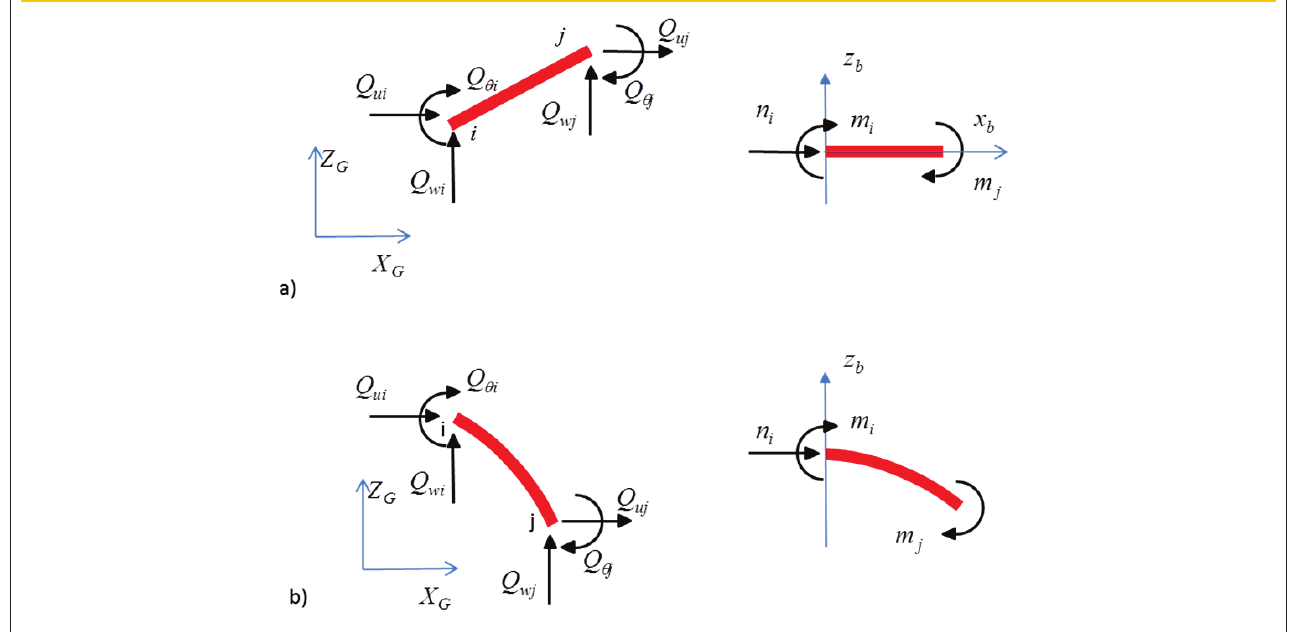
Figure 3 – Internal forces and generalised stresses on the: (a) straight and (b) curved